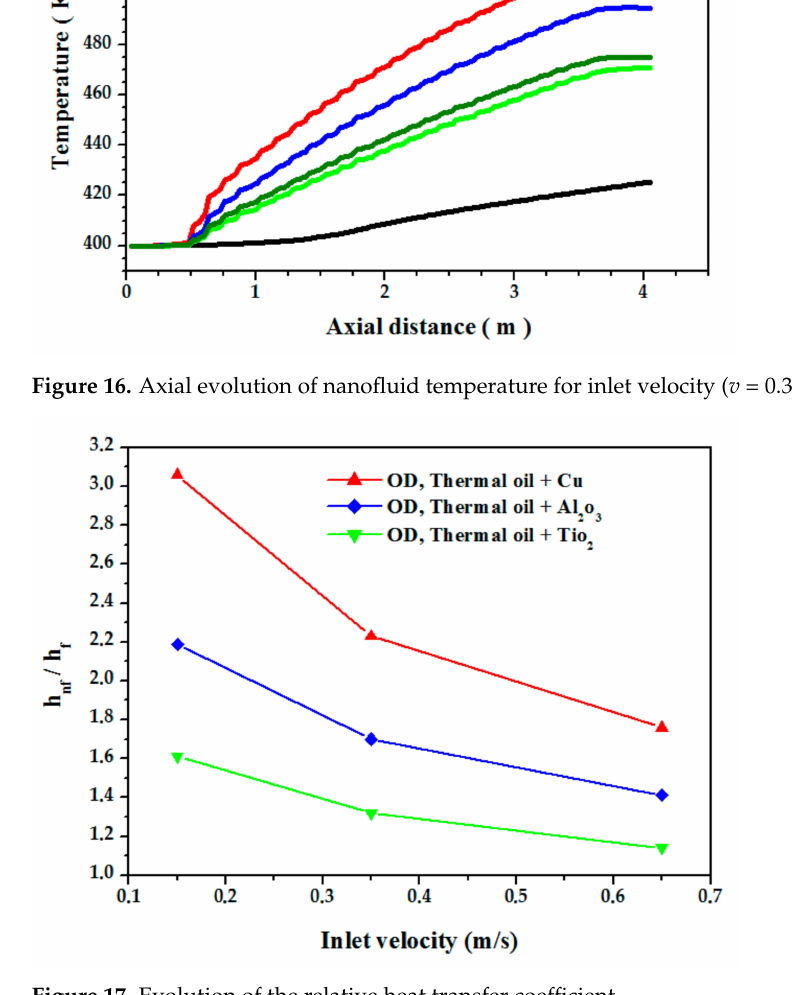
Figure 17. Evolution of the relative heat transfer